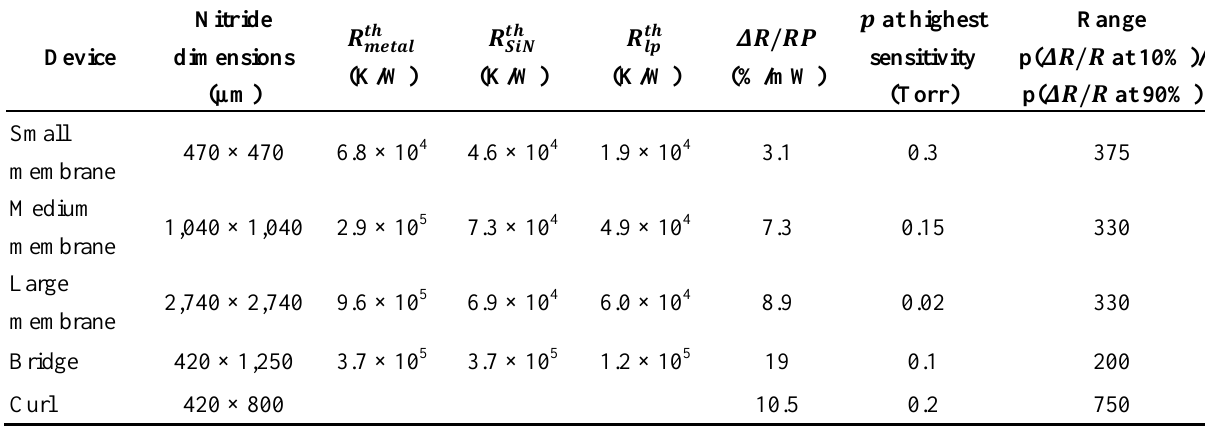
Table 1. Device and performance parameters for the three membranes, the bridge and cantilever devices. The thermal resistances of the metal and silicon nitride of the curled device cannot be obtained using the procedure followed for the other devices due to thermal